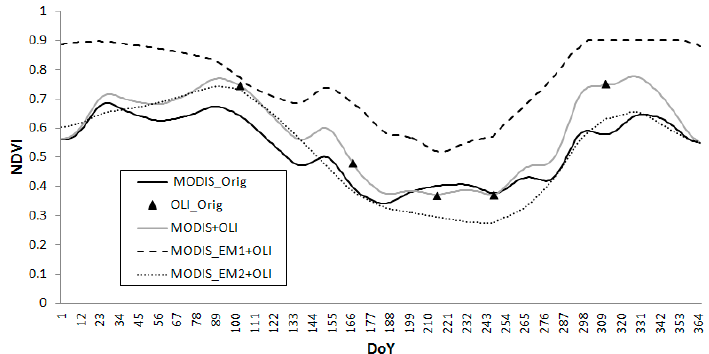
Figure 4. NDVI values of 2013 obtained from MODIS and OLI data ((MODIS_Orig and OLI_Orig, respectively) and integrating OLI with the original MODIS data (MODIS+OLI) and the MODIS endmembers of olive trees and grasses (MODIS_EM1+OLI and MODIS_EM2+OLI, respectively) (see text for details).